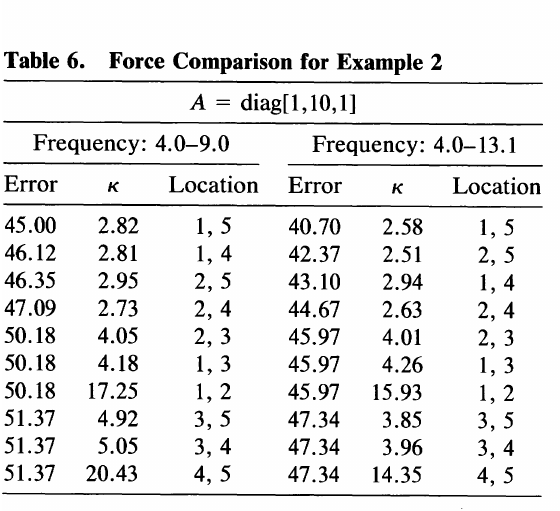
Table 6. Force Comparison for Example